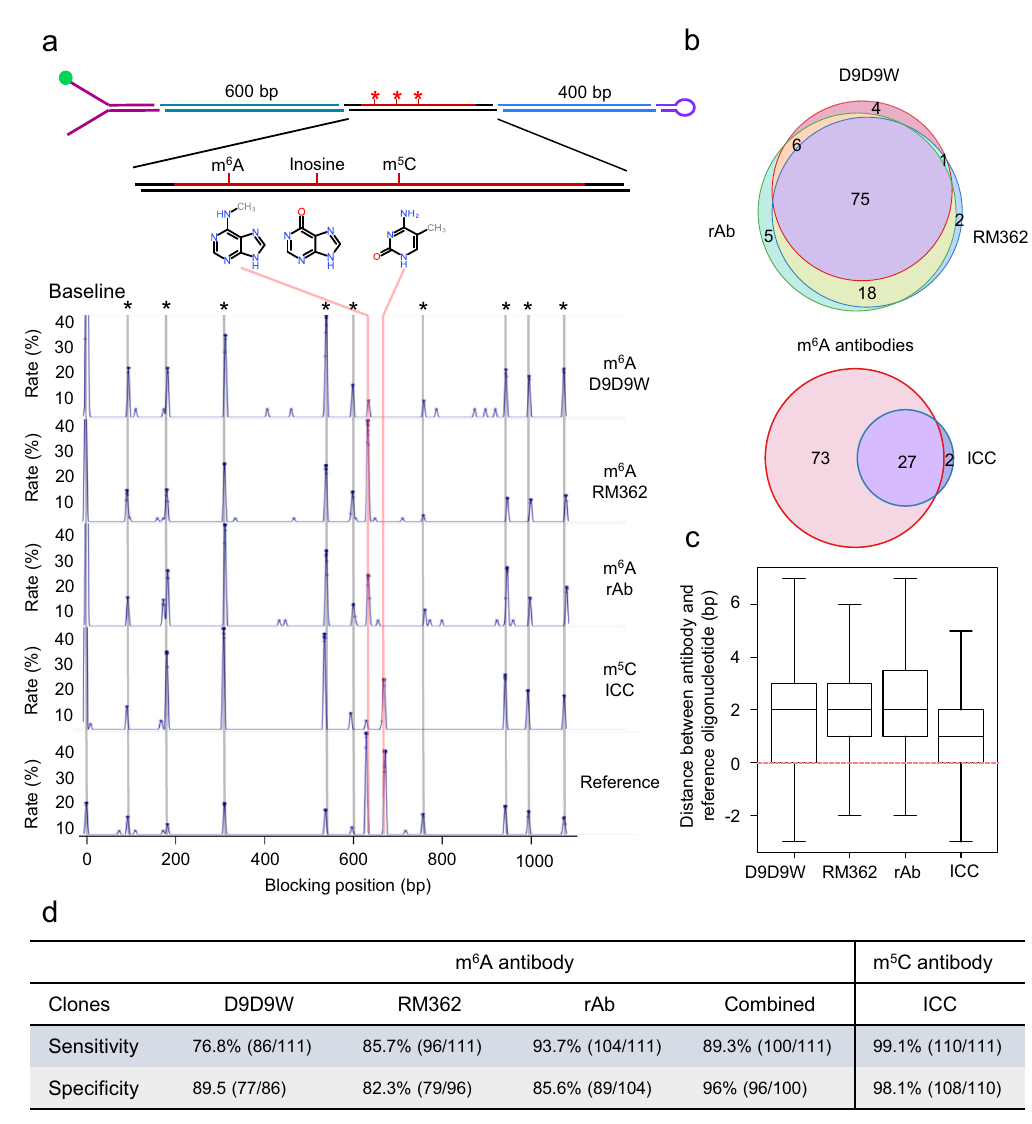
Fig. 4 Detection and mapping of RNA base modi fi cations. a Representation of the synthetic hairpin constructed for epigenetic detection on RNA (see Supplementary Fig. 1 for more details). The red line represents RNA whereas black lines depict DNA. The Y shape adapter, to attach the hairpin on MyOne streptavidin bead via a biotin (green circle), as well as the loop are colored in purple. The binding position histogram of speci fi c antibodies, as well as a reference oligonucleotide mix binding on a single hairpin is shown below. The reference oligonucleotides peaks are marked with an asterisk (*), and are used for alignment. The antibody binding positions are shown by the red lines. The last histogram represents the reference oligonucleotide binding positions that correspond to the same position as the modi fi cation. b Venn diagram showing the overlap between three different m 6 A antibody clones (top). Below, the Venn diagram shows the overlap between non-speci fi c binding identi fi ed by m 5 C antibody (ICC) at the position of m 6 A modi fi cation, and the binding positions identi fi ed by at least two out of three m 6 A antibodies. c Boxplot showing the distance of binding between antibody and the reference oligonucleotides is base pair resolution for all antibodies tested. Whisker boxes represent 50% of the points with the average as a line within the box and the median as a cross. d Table showing the sensitivity and the speci fi city of all three m 6 A antibodies and the m 5 C antibody tested. For the combined analysis of m 6 A antibodies, a binding position was considered as such if it is recognized by at least two out of the three antibodies